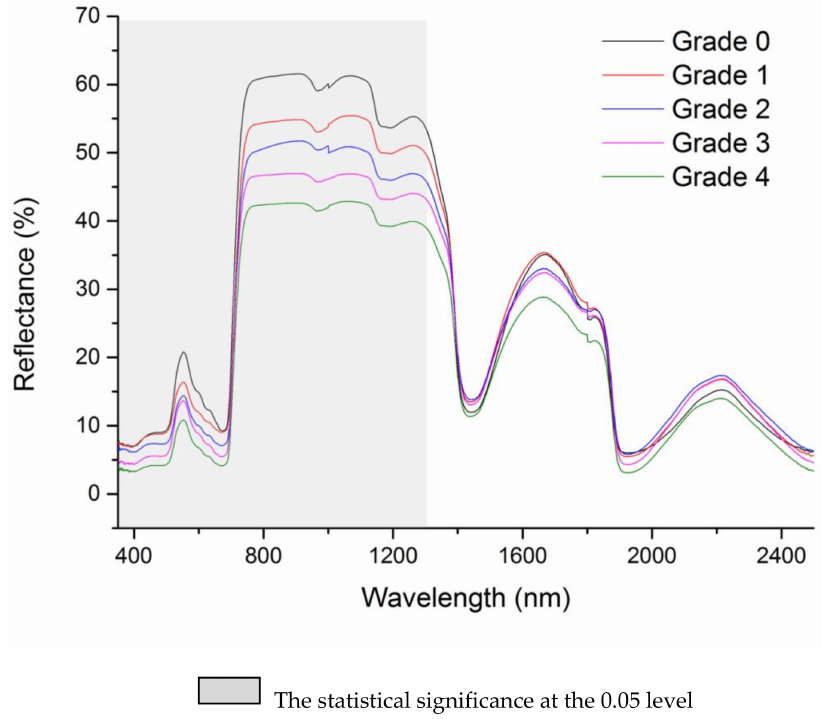
Figure 1. Mean reflectance spectra of cotton plants under different grades of aphid infestation. Table 4. Comparison of leaf reflectance between healthy (Grade 0) and aphid infested cotton plants (Grades 1–4) at five broad-band regions of electromagnetic